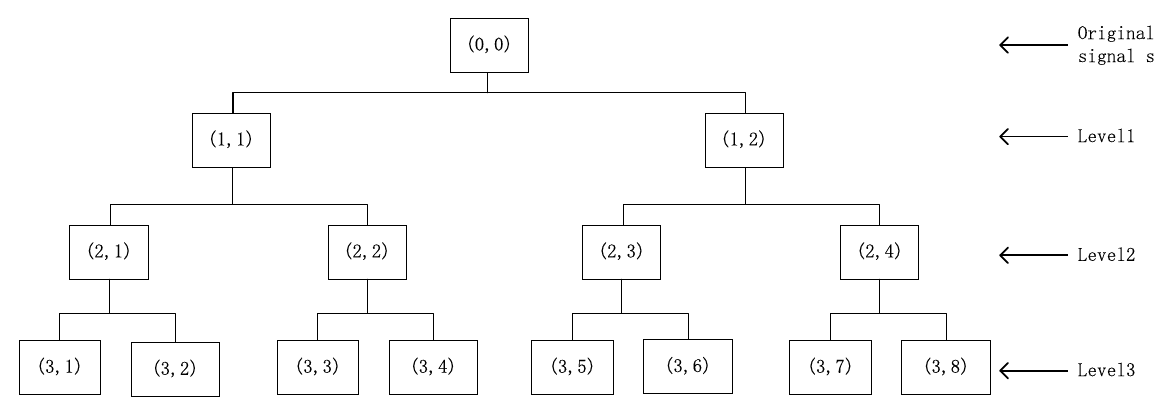
Figure 1. An example of three-level wavelet packet